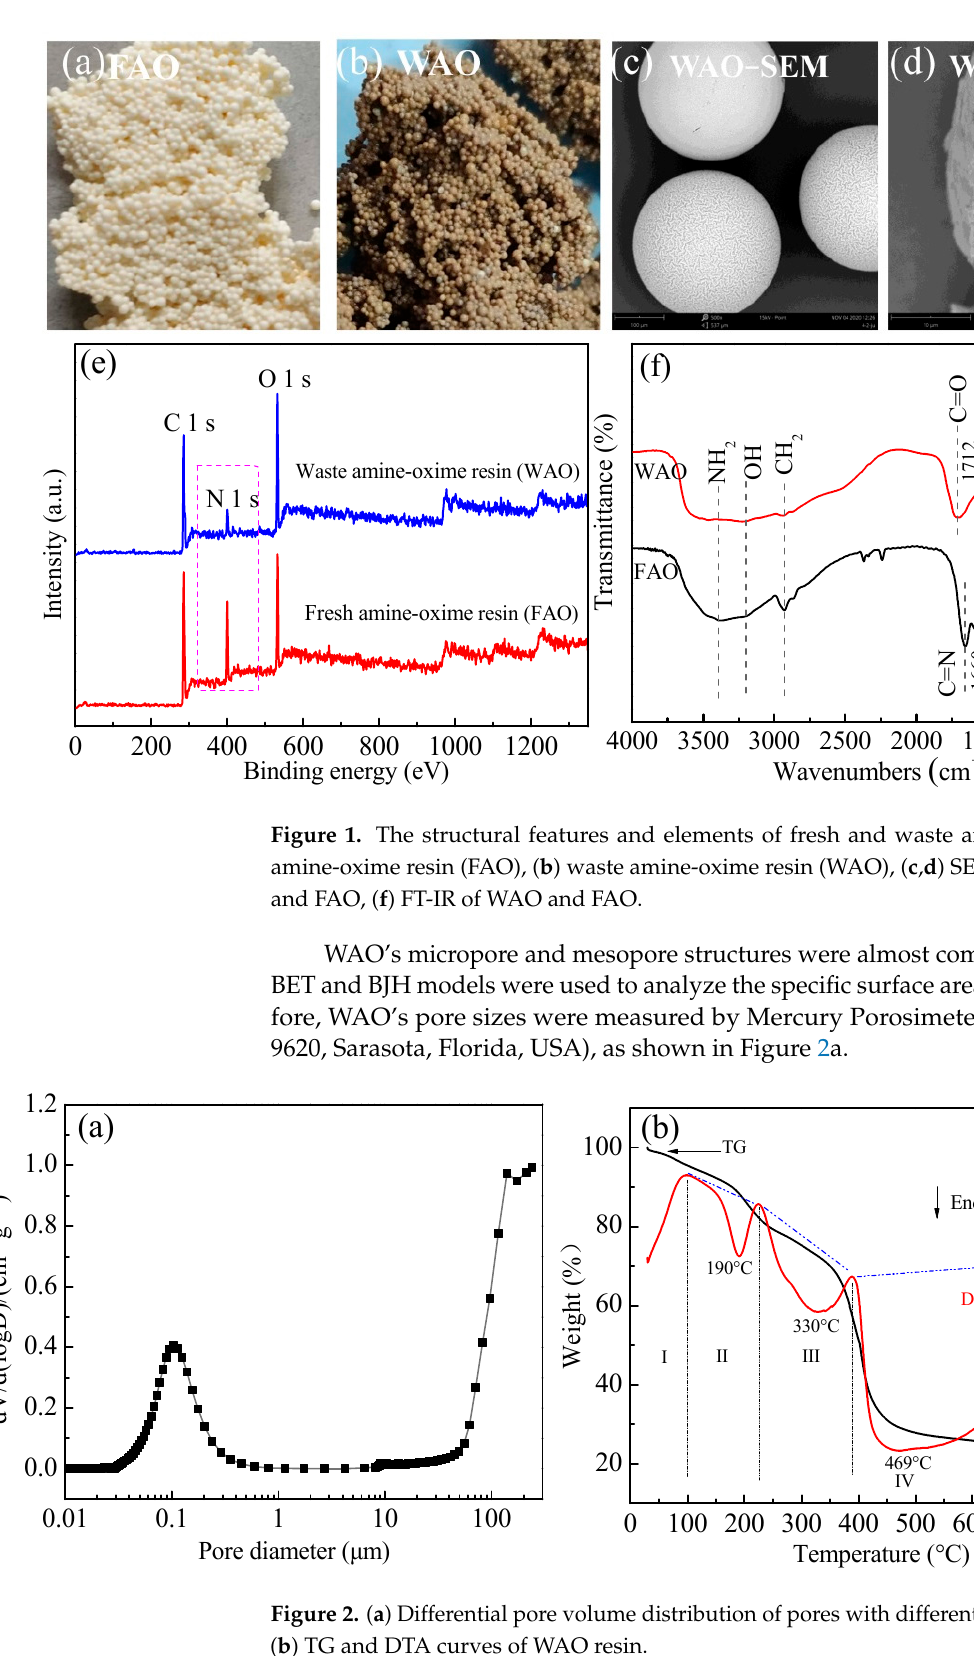
(step III) is attributed to the depolymerization of polystyrene–divinylbenzene structures present in the resin. Finally, the mass of WAO resin rapidly reduced by nearly 24% over the temperature range of 390–600 °C (step IV), possibly due to polystyrene and divi- nylbenzene structure degradation. Therefore, to obtain certain mechanical strength and spherical shape absorbent, the temperature shall be controlled below 220 °C when a mi- crowave is applied to waste resin. 3.2. Characteristics of MT-WAO The microstructure of WAO resin before and after microwave treatment was charac- terized by SEM-EDS, and the obtained images are shown in Figure 3. Figure 3. SEM images of ( a , b )WAO resin ( c , d ) MT-WAO-resin ( e , f ) EDS of MT-WAO resin after adsorbing Pb(II) . No pores could be observed in the WAO resin (Figure 3a, magnified 500 times). The cross-section is rough with uneven holes (Figure 3c) after microwave treatment. When the